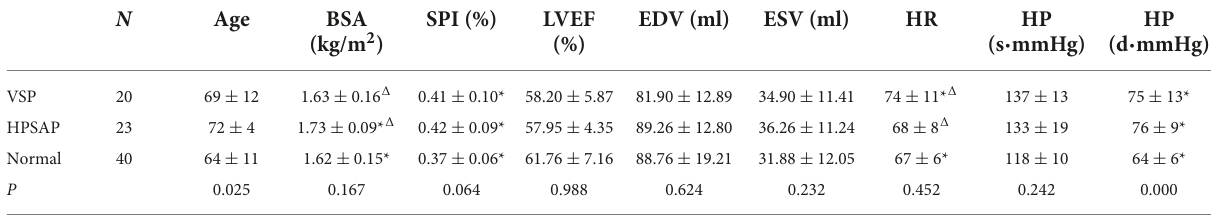
TABLE 1 Comparison of general data between the normal control, ventricular septal pacing (VSP) and His-Purkinje system area pacing (HPSAP)